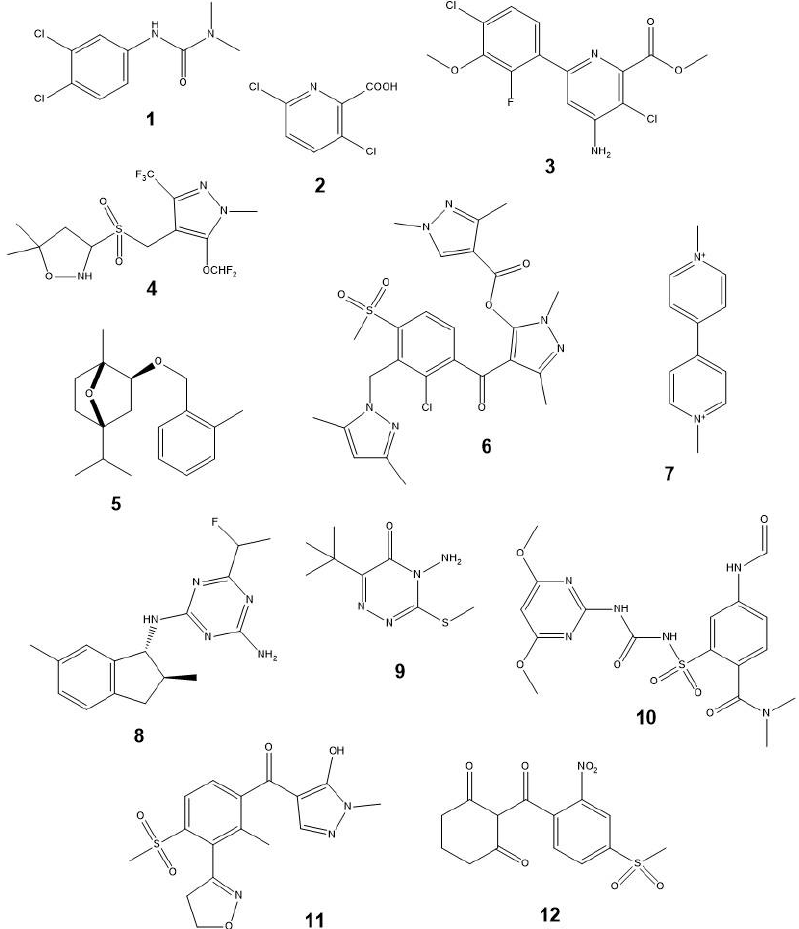
Figure 2. Examples of some common chemical herbicides: 1 —diuron, 2 —clopyralid, 3 —halauxifen- methyl, 4 —pyroxasulfone, 5 —cinmethylin, 6 —tripyrasulfone, 7 —paraquat, 8 —indaziflam, 9 —metribuzin, 10 —foramsulfuron, 11 —topramezone, and 12